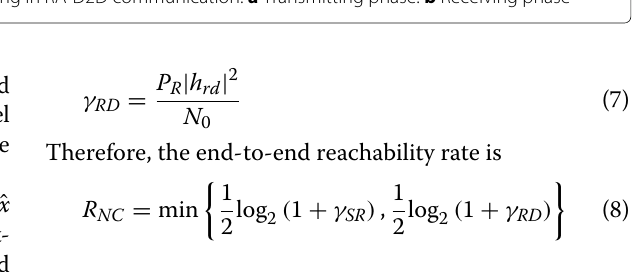
Fig. 4 The two phases of the signal processing based on network coding in RA-D2D communication: a Transmitting phase. b Receiving phase